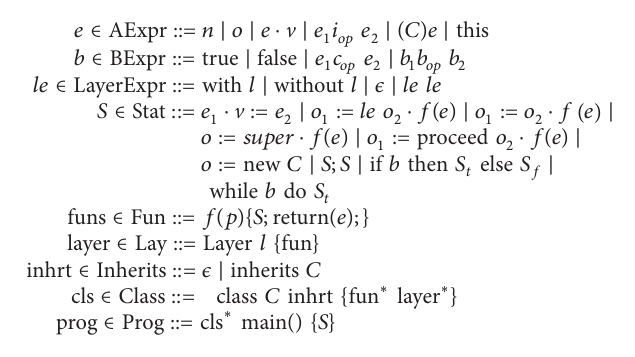
Algorithm 1: The programming language J-COP.